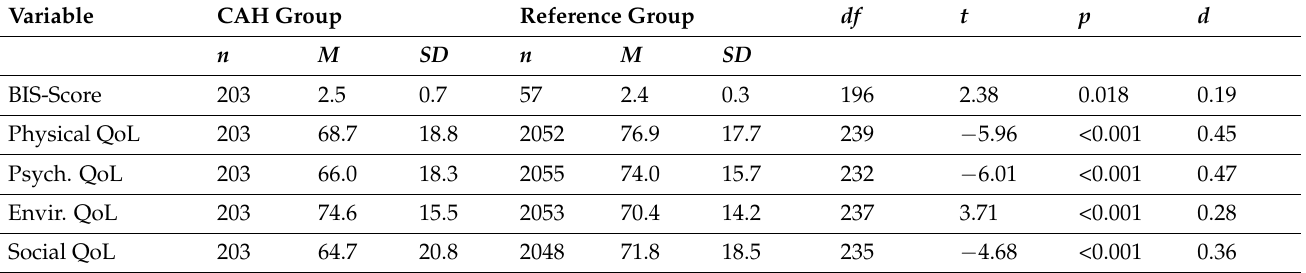
Table 3. Comparison of outcome variables of women with CAH and healthy reference populations.